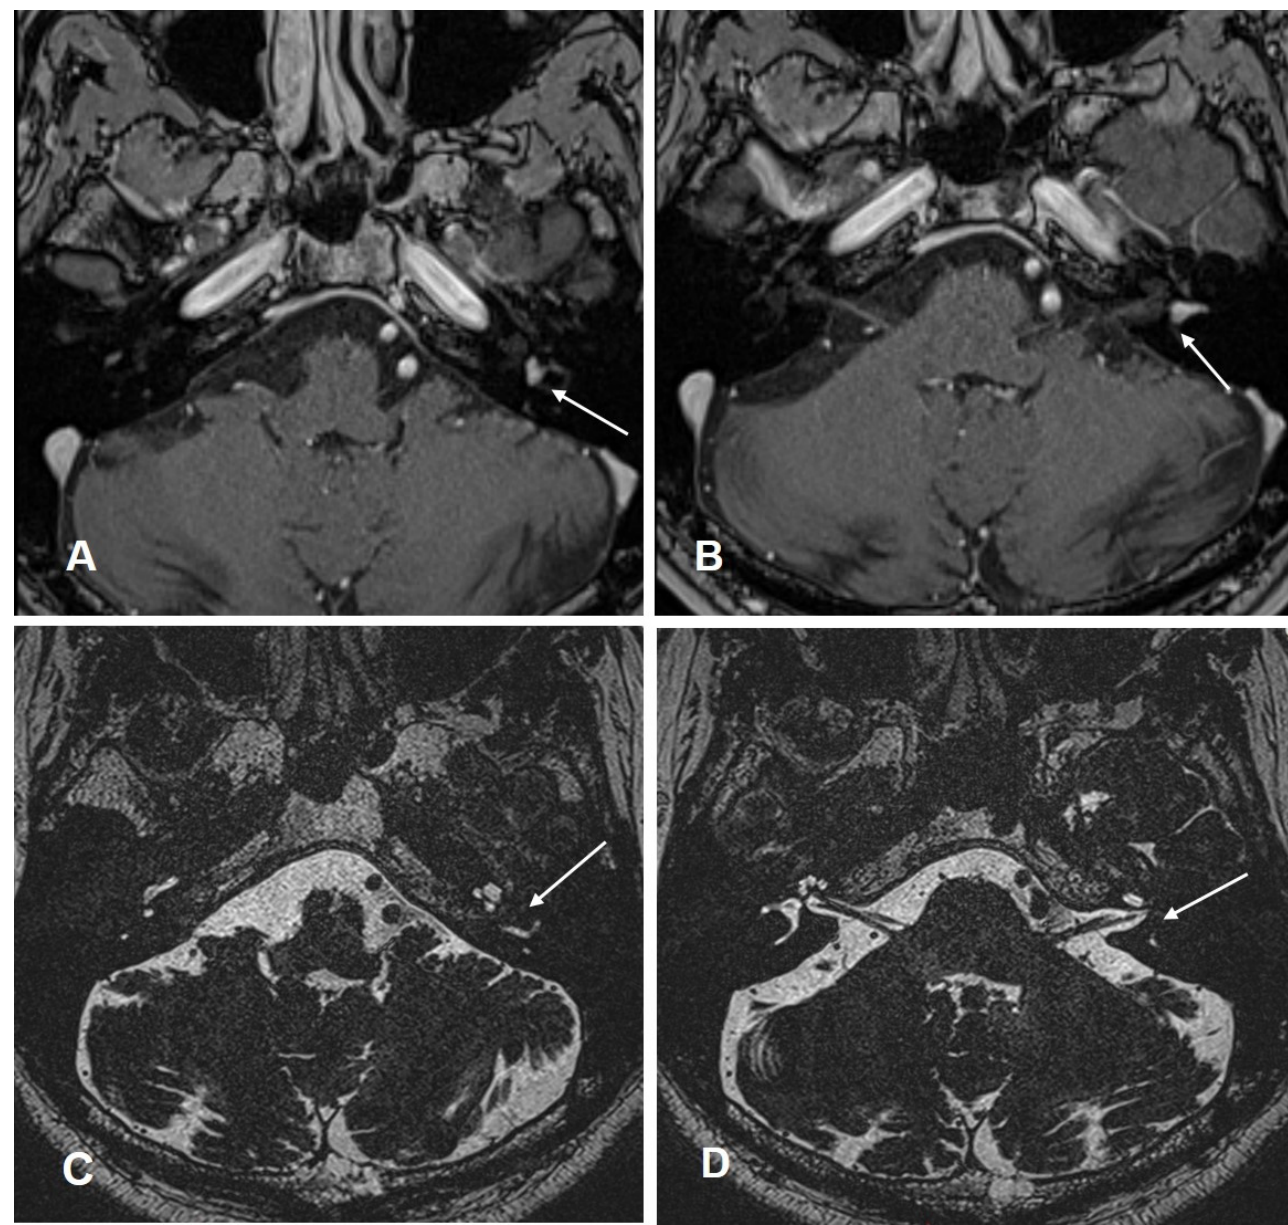
Figure 5. Case #6: cMRI images demonstrating the intravestibular schwannoma. ( A , B ): T1 weighted VIBE 3D with fat saturation prepulses after the intravenous administration of gadolinium. White arrow: intravestibular schwannoma in the ampulla and in the anterior part of the horizontal semicircular canal. ( C , D ): T2 weighted SPACE sequences. ( C ) Intravestibular schwannoma in the anterior part of the horizontal semicircular canal (white arrow). ( D ) ILS in the ampulla (white arrow).